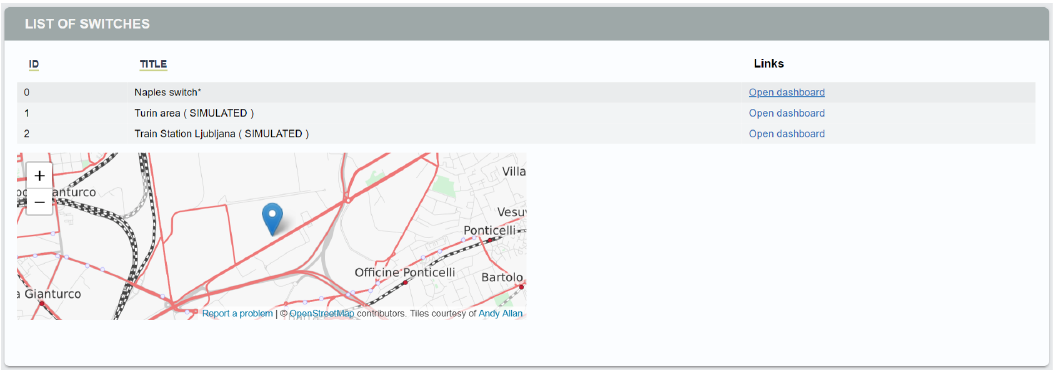
Figure 16. Support for the multiple railway switch